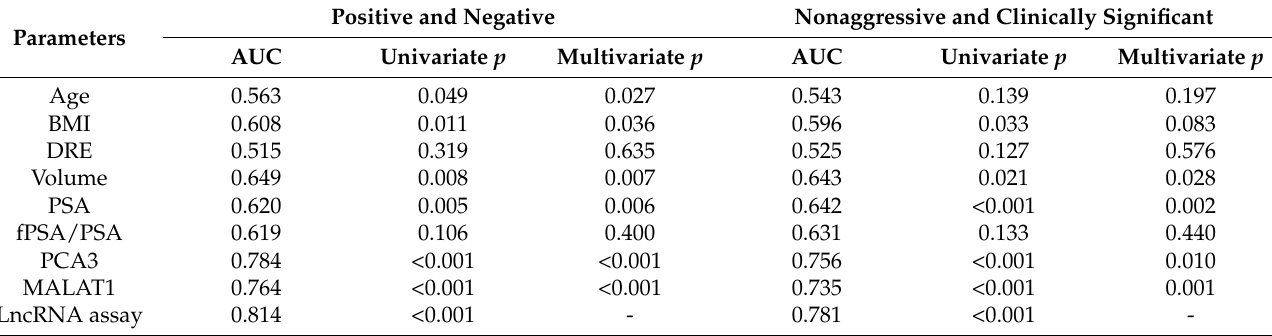
Table 3. Performance of the lncRNA assay and PCa-associated clinical features in predicting biopsy results in the validation